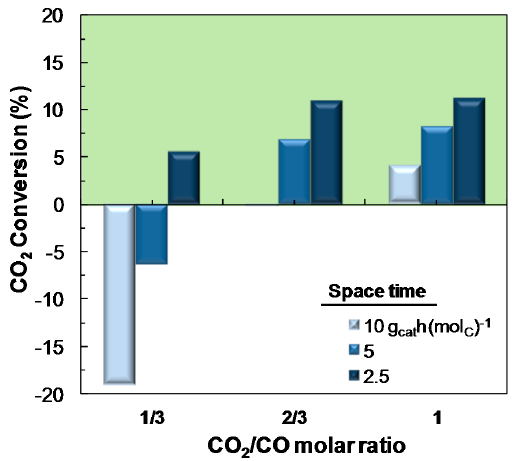
Figure 7. Effect of CO 2 /CO molar ratio in the feed on the CO 2 conversion (or CO 2 yield, for negative values), for different space time values. Reaction conditions: Feed, H 2 + CO + CO 2 with H 2 /CO x molar ratio of 3; 275 °C; 30 bar.